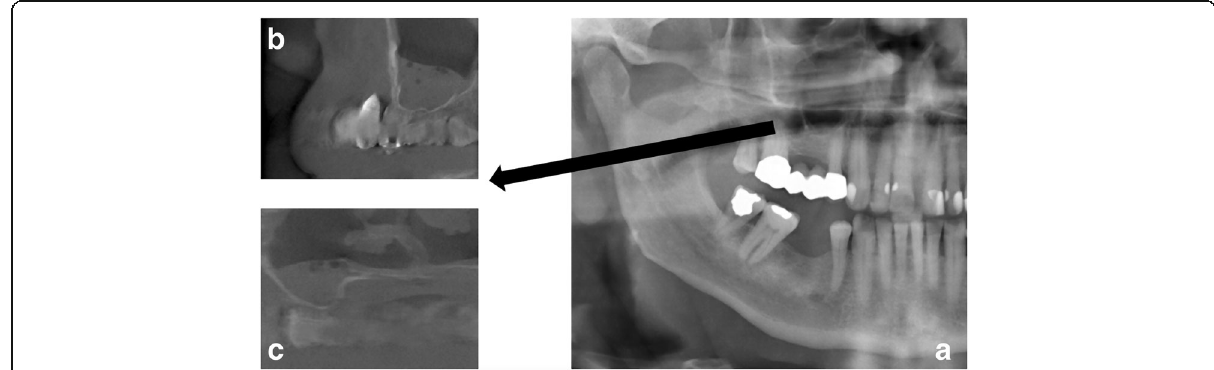
Fig. 1 a Panoramic radiography with area of interest (maxillary sinus) and b , c examples of corresponding images in cone beam computed tomography